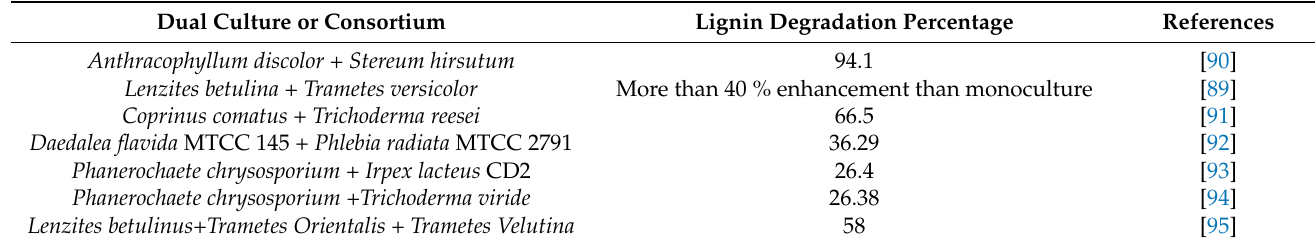
Table 5. Co-culture system with improved lignin